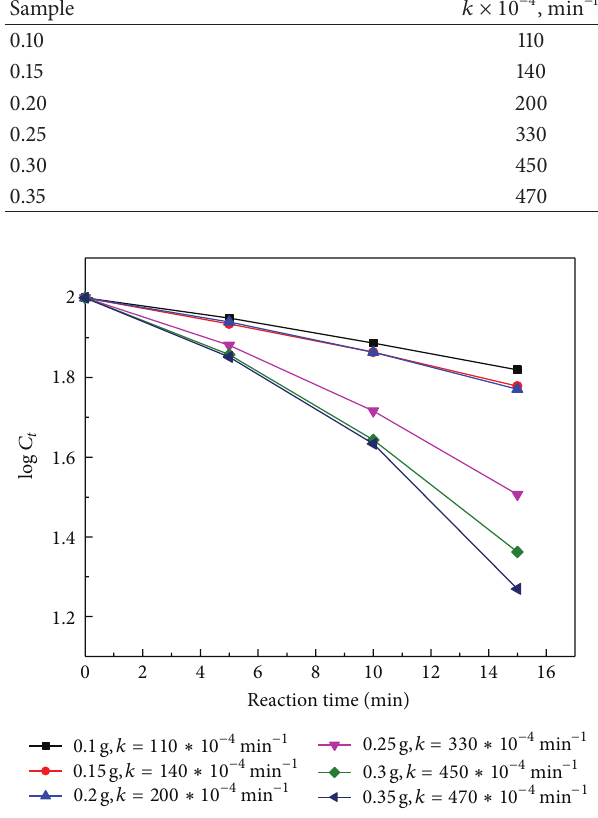
Figure 8: The effect of loading of 0.3 wt% Pt/ZrO 2 -SiO 2 on the rate constant of CN −